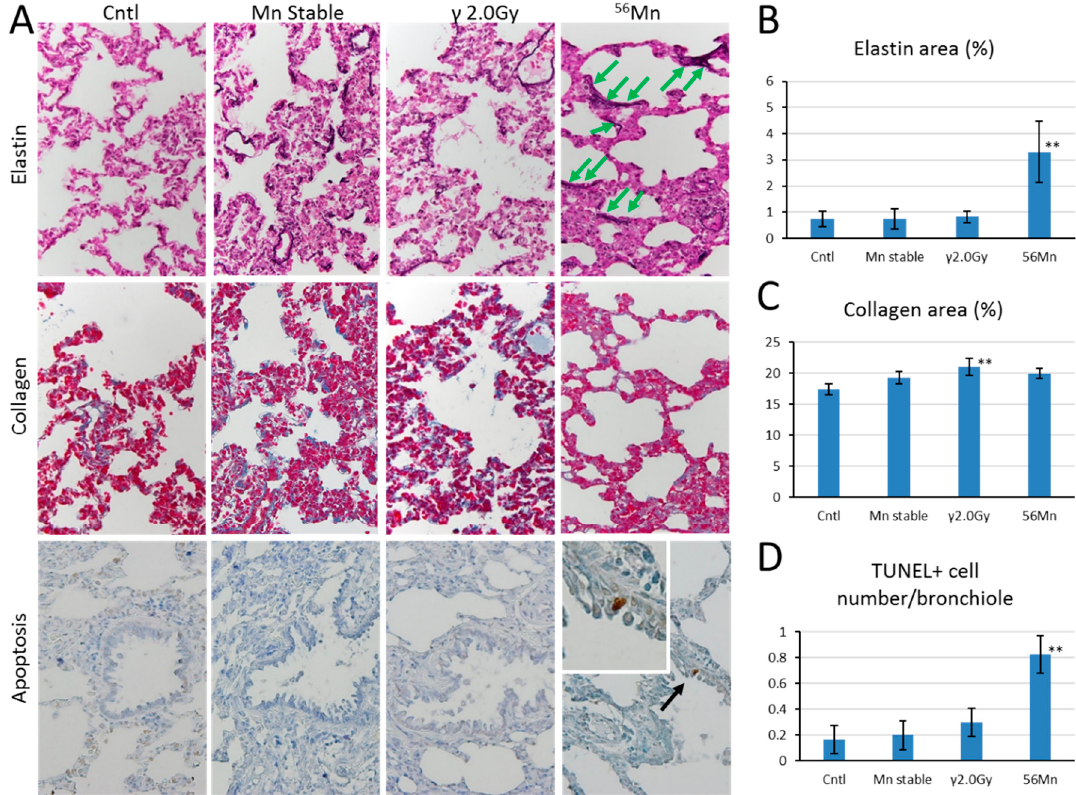
Figure 4. Comparison of elastin and collagen late deposition 8 months and apoptosis effects 2 months after internal ( 56 Mn(1 × )) and external radiation exposure. ( A ) Lung sections from rats were prepared after exposure and were evaluated for elastin deposition (purple black) identified via Verhoeff–Van Gieson staining and collagen deposition (blue) identified via Azan–Mallory staining and the presence of apoptotic cells (brown, black arrow) in bronchioles identified via TUNEL staining. Broken elastin fibers were observed (green arrows). Original magnification 40 × . Representative images of control rat (0 Gy), Mn stable exposure rat, γ 2.0 Gy irradiated rat (2.0 Gy) and 56 Mn irradiated rat are shown in panels. Radiation induced changes in percentage elastin area ( B ), percentage collagen area ( C ) and number of TUNEL positive cells in bronchioles ( D ), were determined using cellSens Dimension image acquisition and computer-aided quantification of sampled images. Bars, mean ± SEM ( n = 3–6). Significantly different (** p <0.01) from 0 Gy irradiated controls. 40 × ( A ) objective magnification.